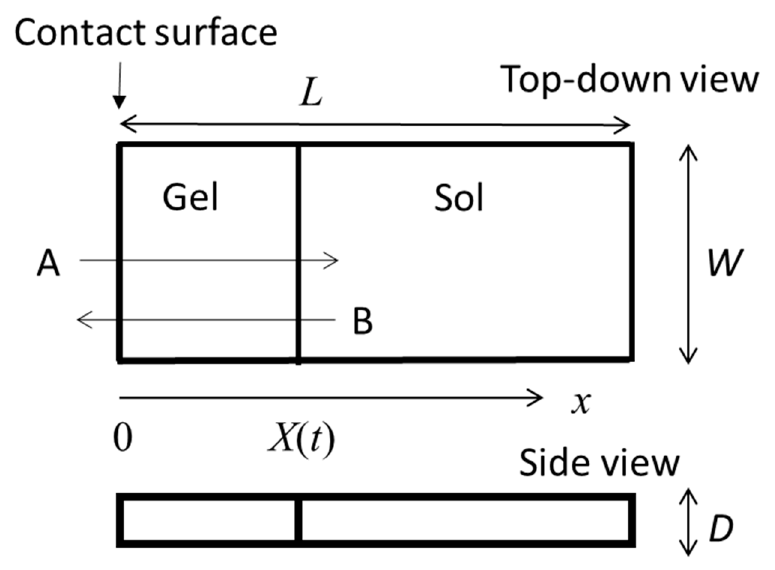
Figure 1. Illustration of one-dimensional gel layer growth from the contact surface between polymer solution enclosed in an L (length) × W (width) × D (depth) rectangular cell in an immersing gelator solution (left-hand side of the cell) induced by inflow of A and outflow of B. The x -axis is chosen to be perpendicular to the contact surface and is oriented in the direction from the immersing gelator solution to the polymer solution. The origin of the x -axis is chosen at the contact interface. X ( t ) denotes the gel layer thickness at immersion time t . In the gelation of chitosan solution, the gelator solution and polymer solution are NaOH aqueous solution and chitosan in acetic acid aqueous solution, respectively.